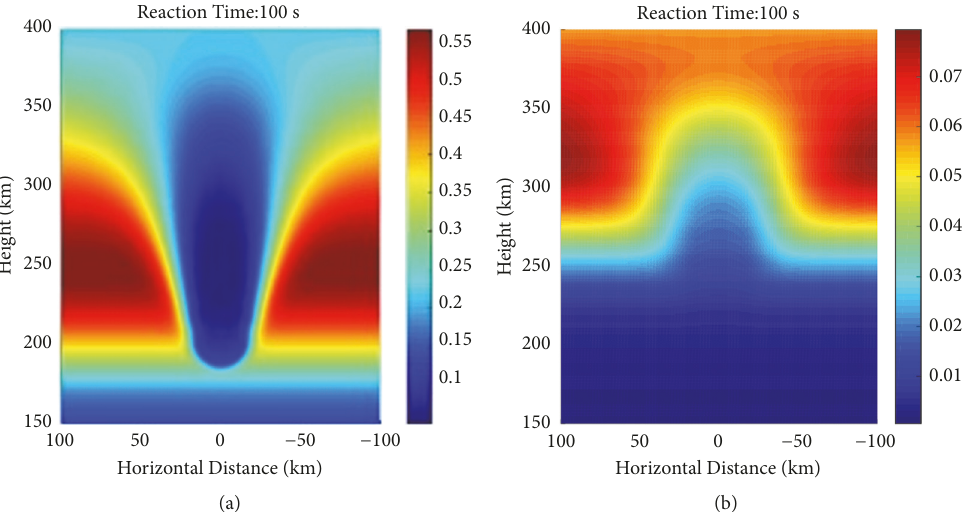
Figure 4: (a) Electron density profile of H 2 O released from the ionosphere during the day; (b) electron density profile of H 2 O released from the ionosphere during the